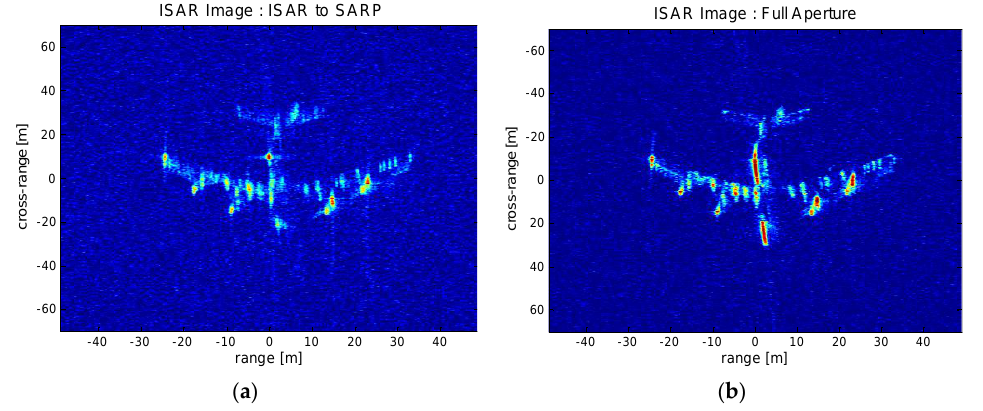
Figure 14. Processed high resolution ISAR image (Boeing 747): ( a ) Sliced aperture data limited by PRF aperture; ( b ) Full aperture data.